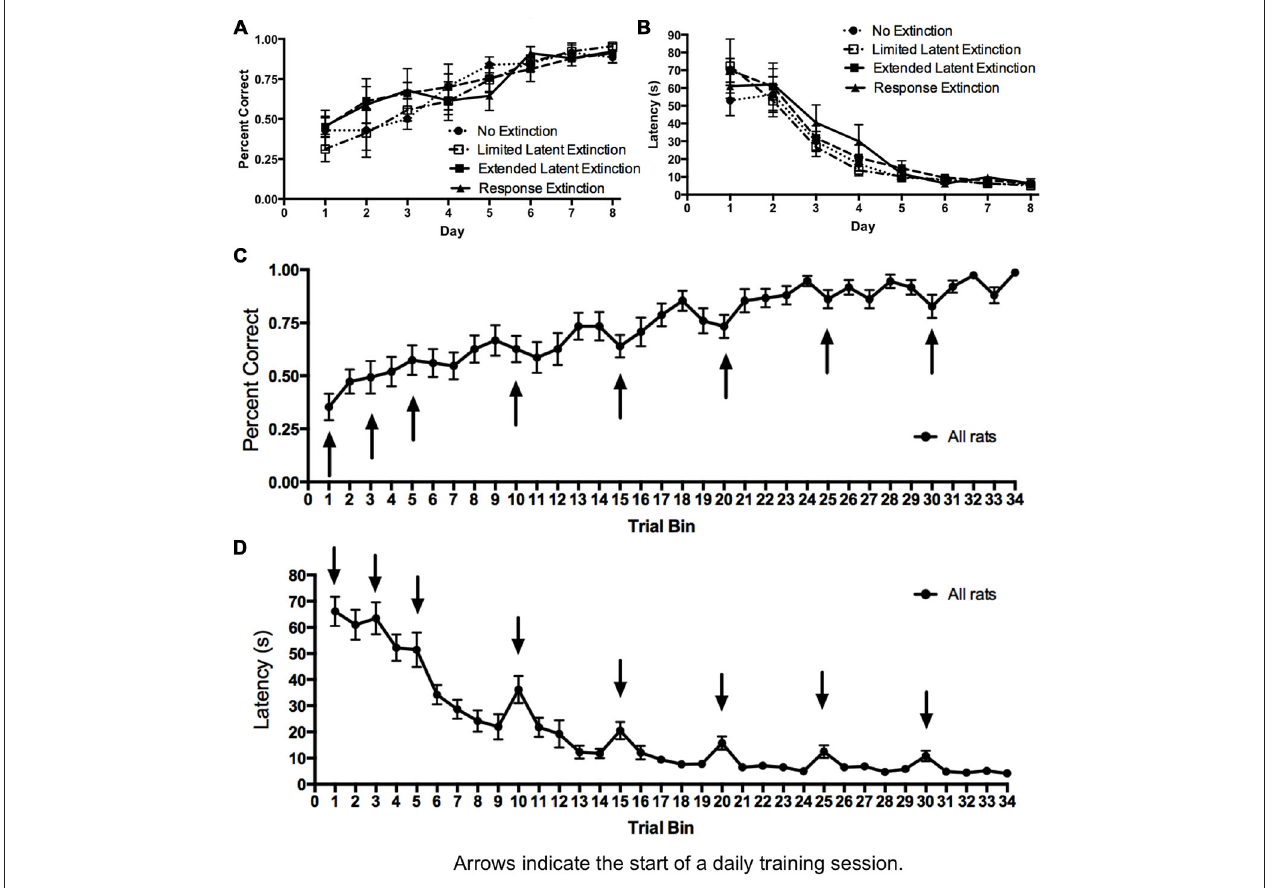
FIGURE 4 | Acquisition of DLS-dependent response learning in the plus-maze. (A,B) The percentage of correct turns increased (A) and the latency to reach the correct food well decreased (B) over the course of training in the response learning task. There were no differences between groups, suggesting all groups acquired the task about equally. (C,D) All groups were combined, and the trials of each day were averaged into trial bins (1 trial bin = 3 trials). Animals were more likely to make incorrect turns (C) and were slower (D) on the first few trials of a given training day vs. the last few trials of the previous